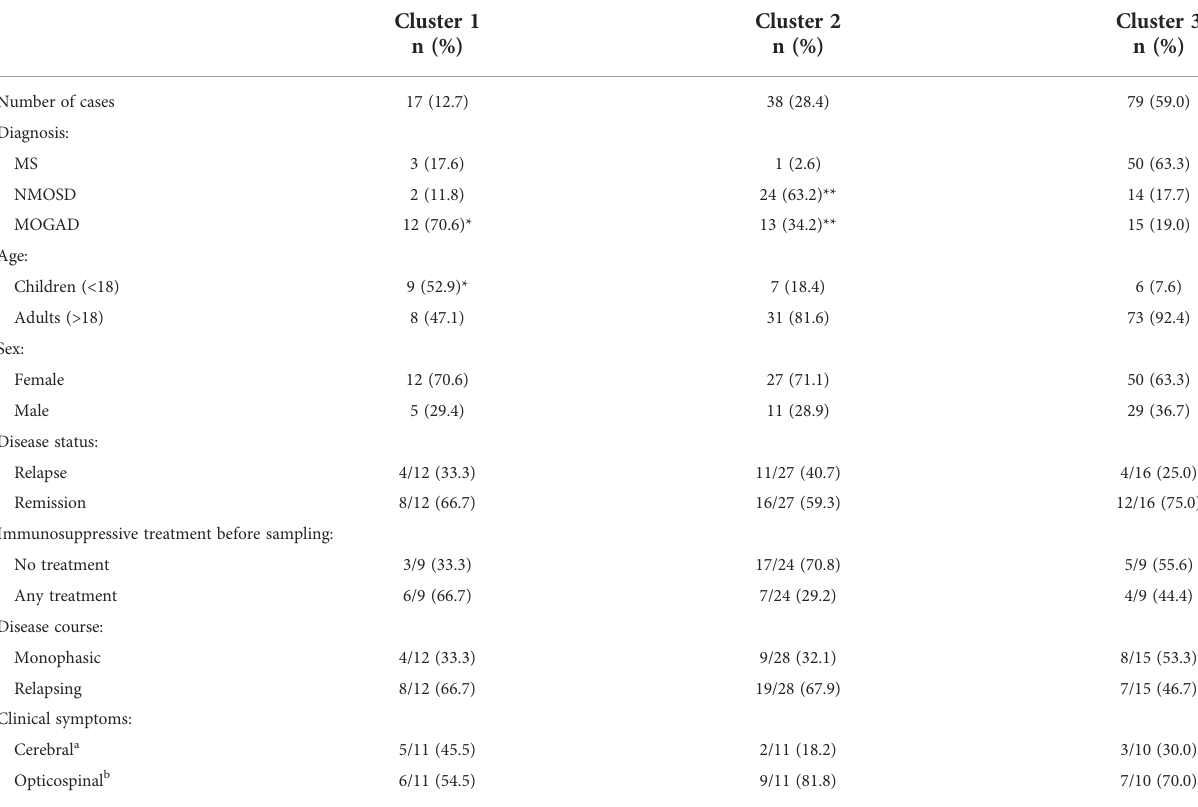
TABLE 2 Describing characteristics of clusters, distinguished by similar cytokine/chemokine pro fi